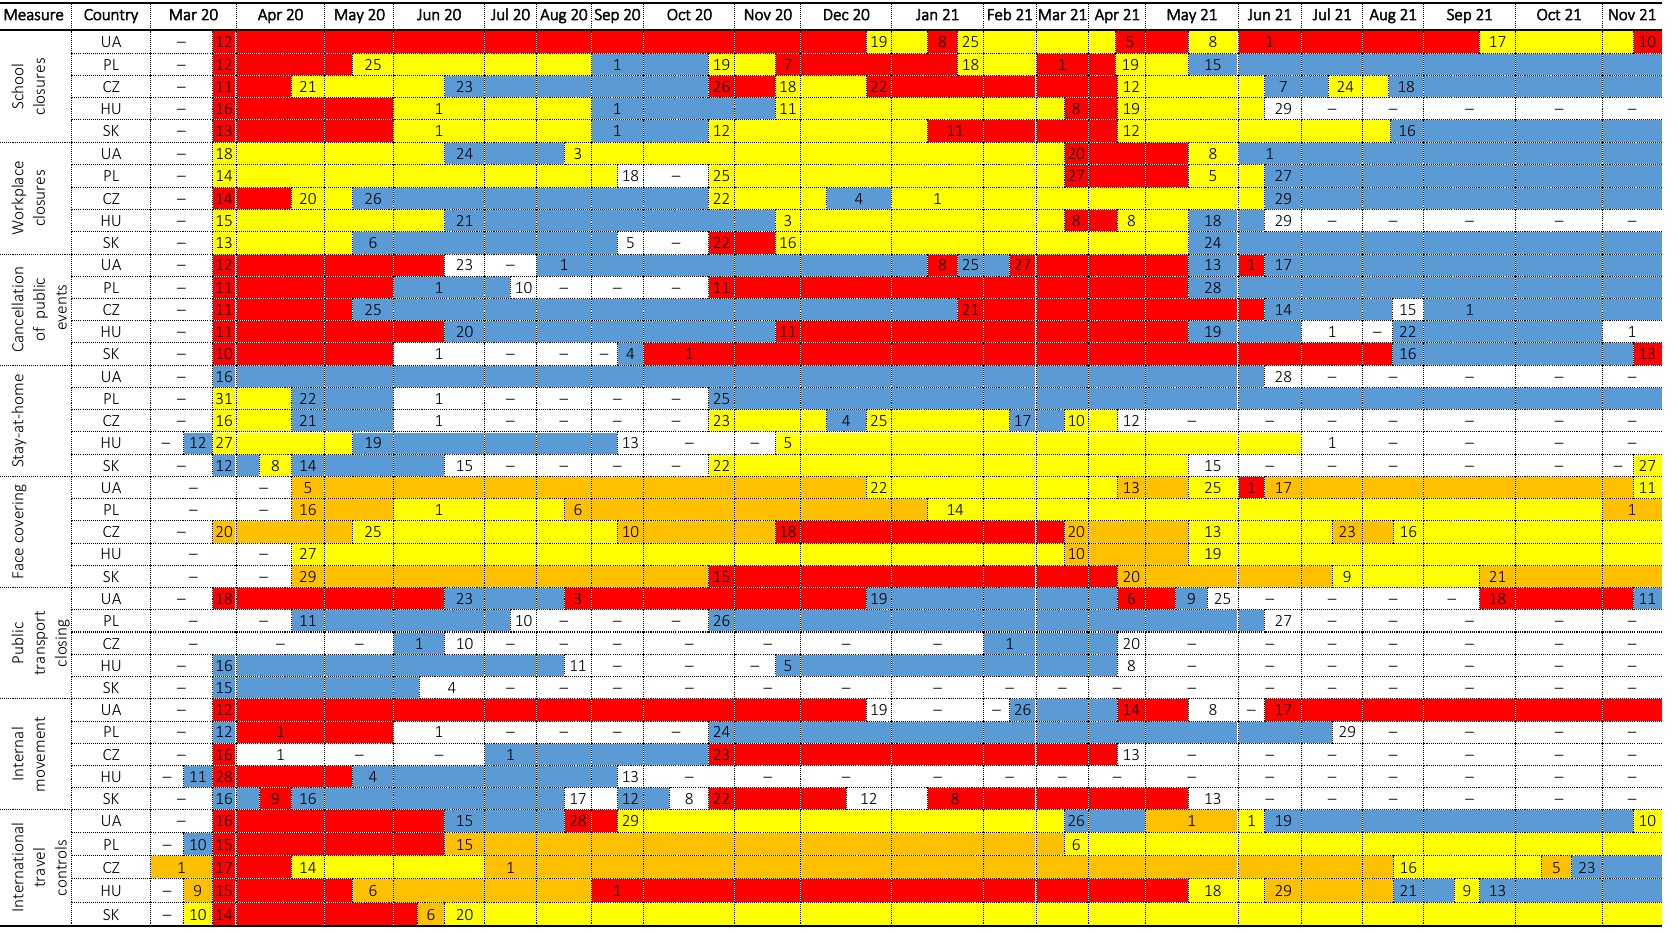
Table 1. Timeline dashboard of quarantine measures for Ukraine and Visegrad Group countries, March 2020–November 2021